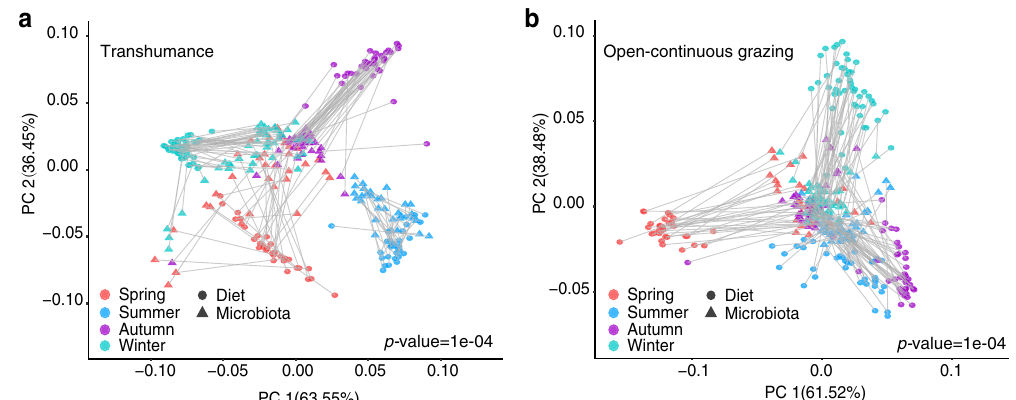
Fig. 5 Seasonal clustering patterns in diet – microbiota lineages of yak in transhumance and open-continuous grazing regimes. The diet and microbiota compositions are determined with Bray – Curtis distance in ( a ) transhumance and ( b ) open-continuous grazing regimes, which are colored by season. Procrustes rotates the results of separate principal coordinates of diet composition (circle symbols) and gut microbiota composition (triangle symbols). Signi fi cant dissimilarities occurred between diet and microbiota ordinations by p -value.